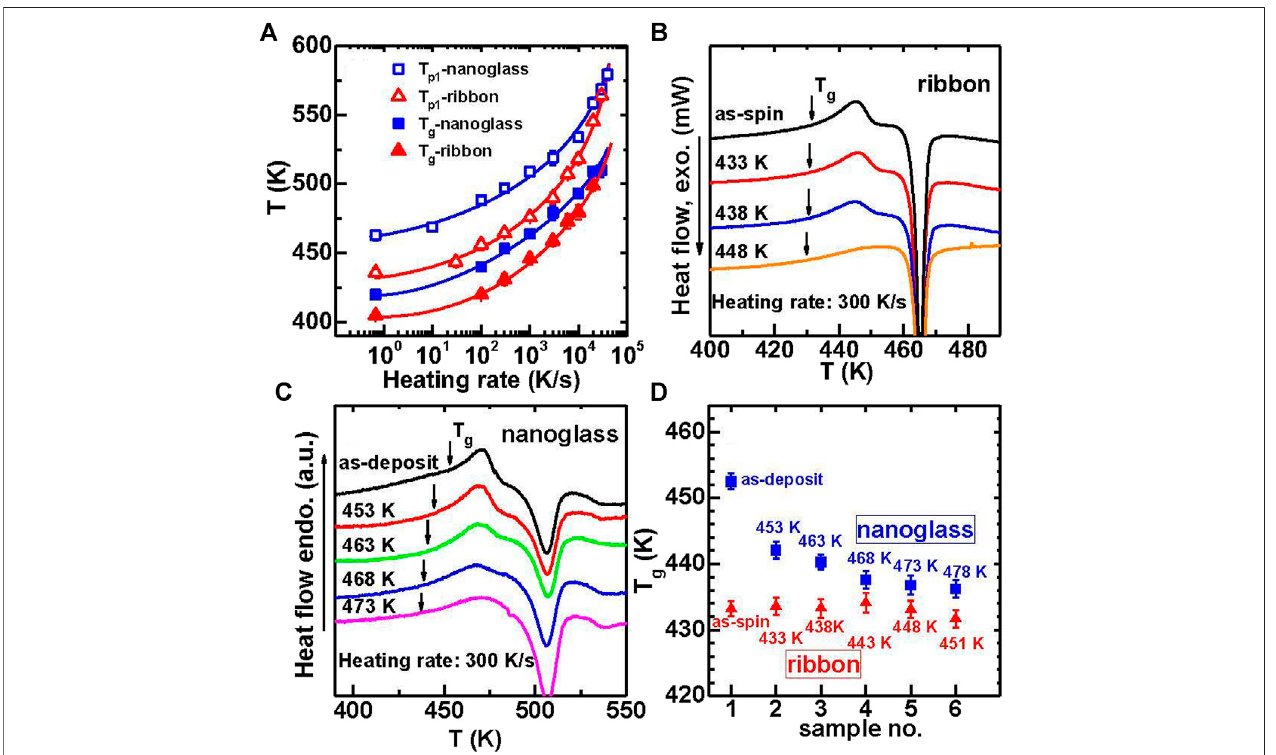
FIGURE 19 | (A) The evolution of T g (solid symbols) and T p1 (open symbols) with different heating rate for both Au 52 Ag 5 Pd 2 Cu 25 Si 10 Al 6 nanoglass (squares) and ribbon (triangles). DSC heat fl ow curvesafter pre-annealing to different temperatures for (B) ribbon and (C) nanoglass. (D) T gevolution with temperaturesfor ultrastable nanoglass (squares) and ribbon (triangles) after pre-annealing (from (Wang J. Q. et al., 2014)).